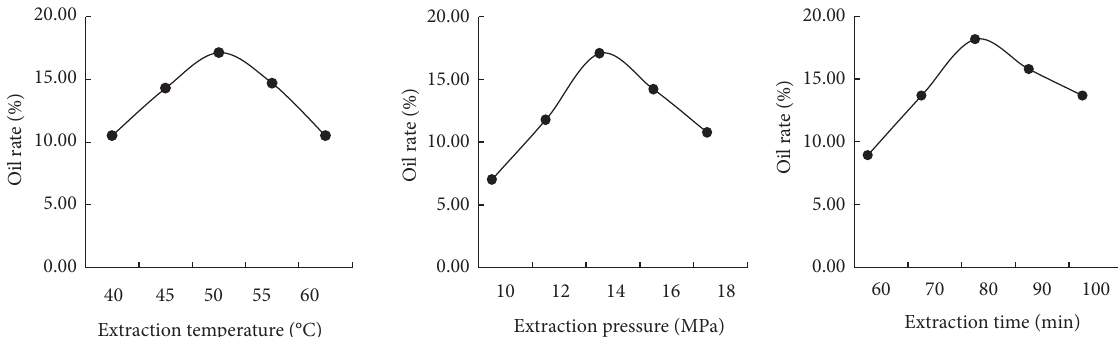
Figure 3: Influence of different factors on oil yield of palm seed by supercritical extraction.